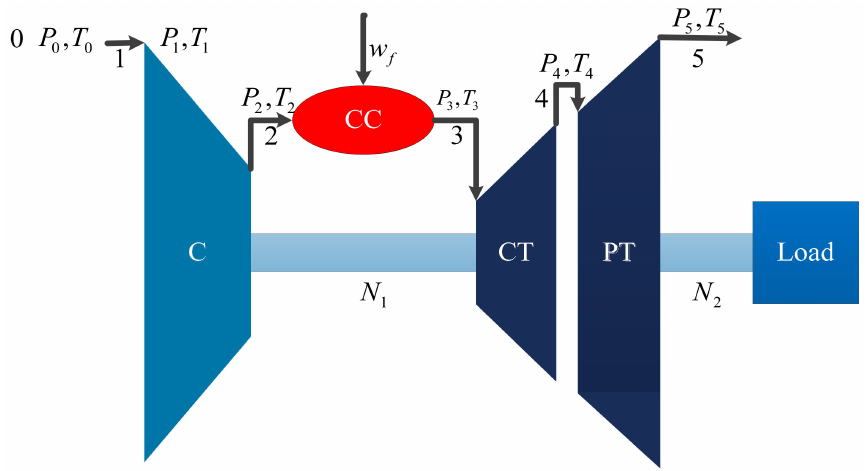
Figure 3. The layout of a two-shaft marine gas turbine. T 0 is the inlet temperature of the compressor and P 0 is the ambient pressure; T 2 and P 2 are the compressor outlet temperature and outlet pressure, respectively, and N 1 is the compressor speed; w f is the fuel mass flow which sprays into the combustion chamber to produce outlet temperature T 3 and outlet pressure P 3 ; T 4 and P 4 are the exhaust gas temperature and pressure of the compressor turbine, respectively; T 5 and P 5 are the outlet temperature and outlet pressure of the power turbine, respectively, and N 2 is the power turbine